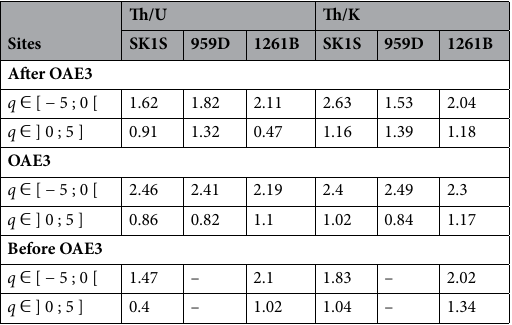
Table 2. Slope values of mass exponent τ ( q ) for thorium–uranium and thorium–potassium distributions before, within and the OAE3 intervals at Songliao Basin (SK1S), Deep Ivorian Basin (959D) and Demerara Rise (1261B).